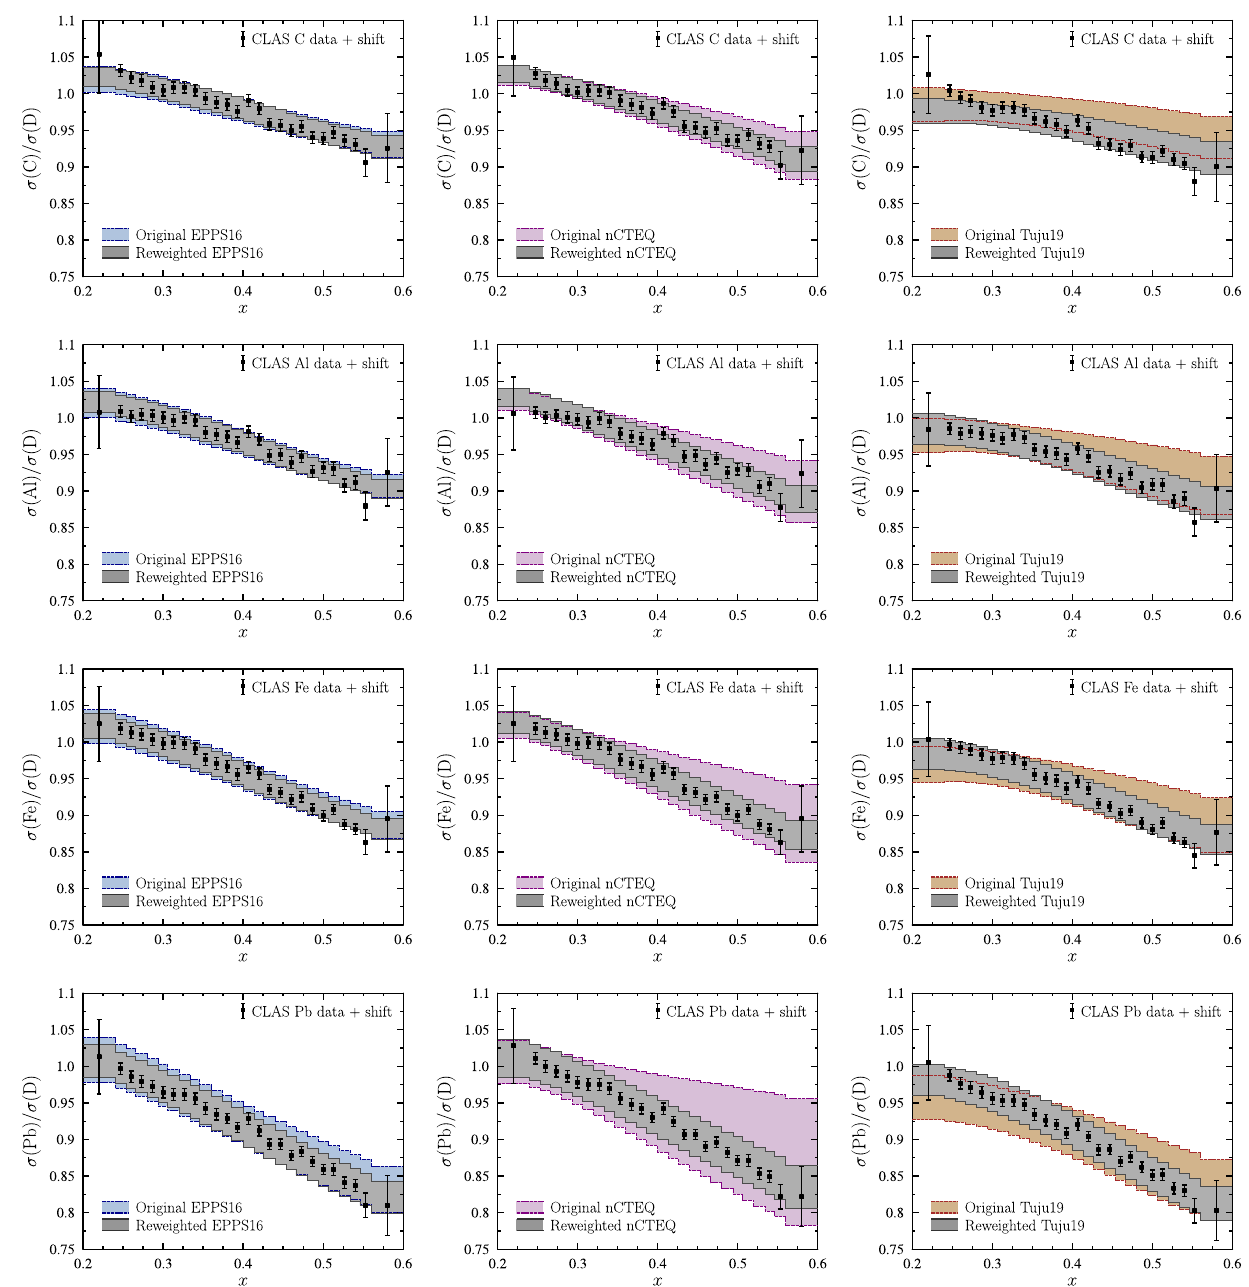
Fig. 4 The CLAS data compared with the re-weighted nuclear-PDF predictions. The optimal shifts that minimize Eq. (12) with the central re-weighted predictons, have been applied to the data points. The normalization uncertainties are not included in the data error bars